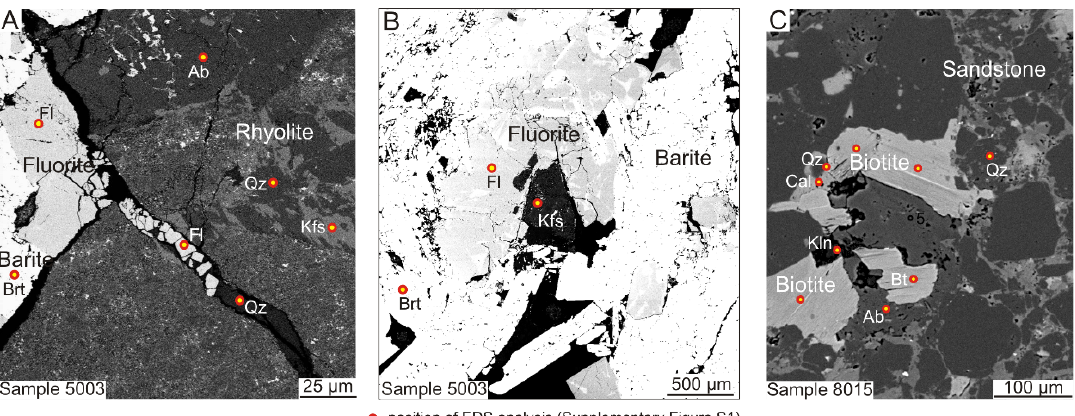
Figure 5. ( A , B ) Backscattered electron images of veins of fluorite and barite in rhyolite, Squally Point. ( C ) Secondary biotite in calcite-cemented sandstone, Five Islands. Mineral abbreviations as in Table 1.